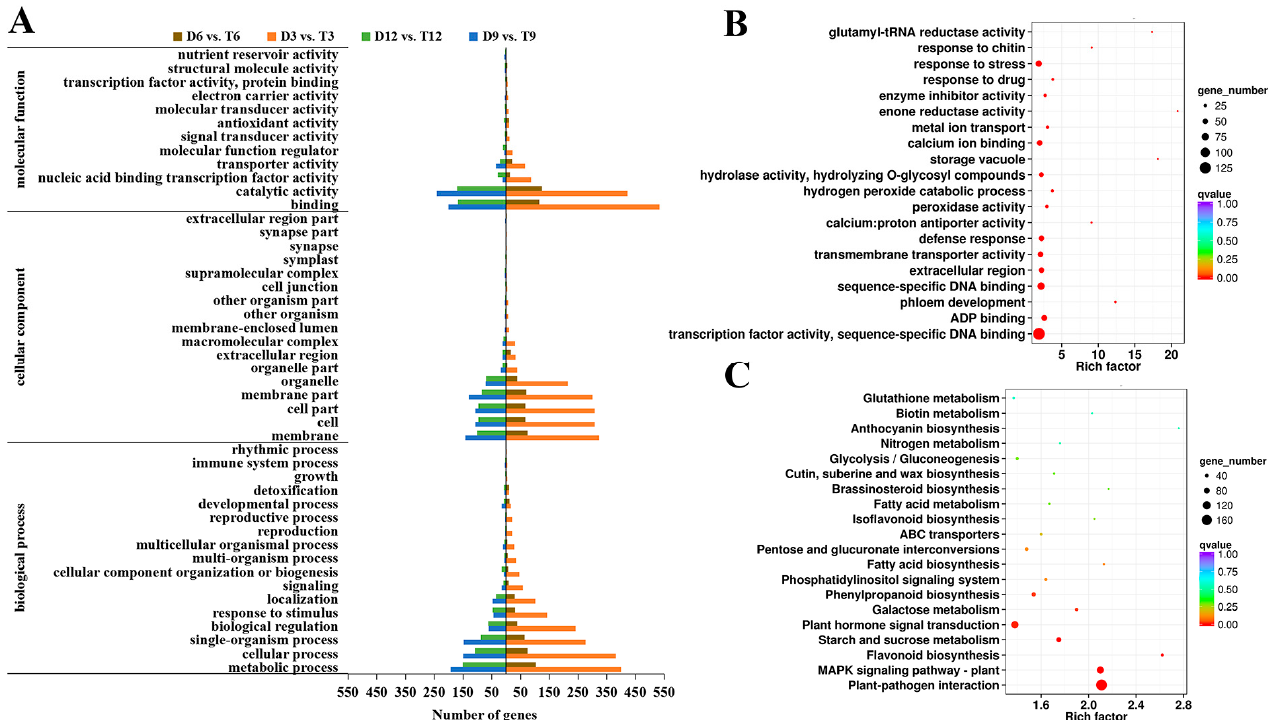
Figure 5. Preliminary analysis of the biological functions of DEGs from diploids and tetraploids. ( A ) Level-2 GO functional classifications of DEGs from diploids and tetraploids. ( B ) GO enrichment analysis of all DEGs from diploids and tetraploids. ( C ) KEGG enrichment analysis of all DEGs from diploids and tetraploids.